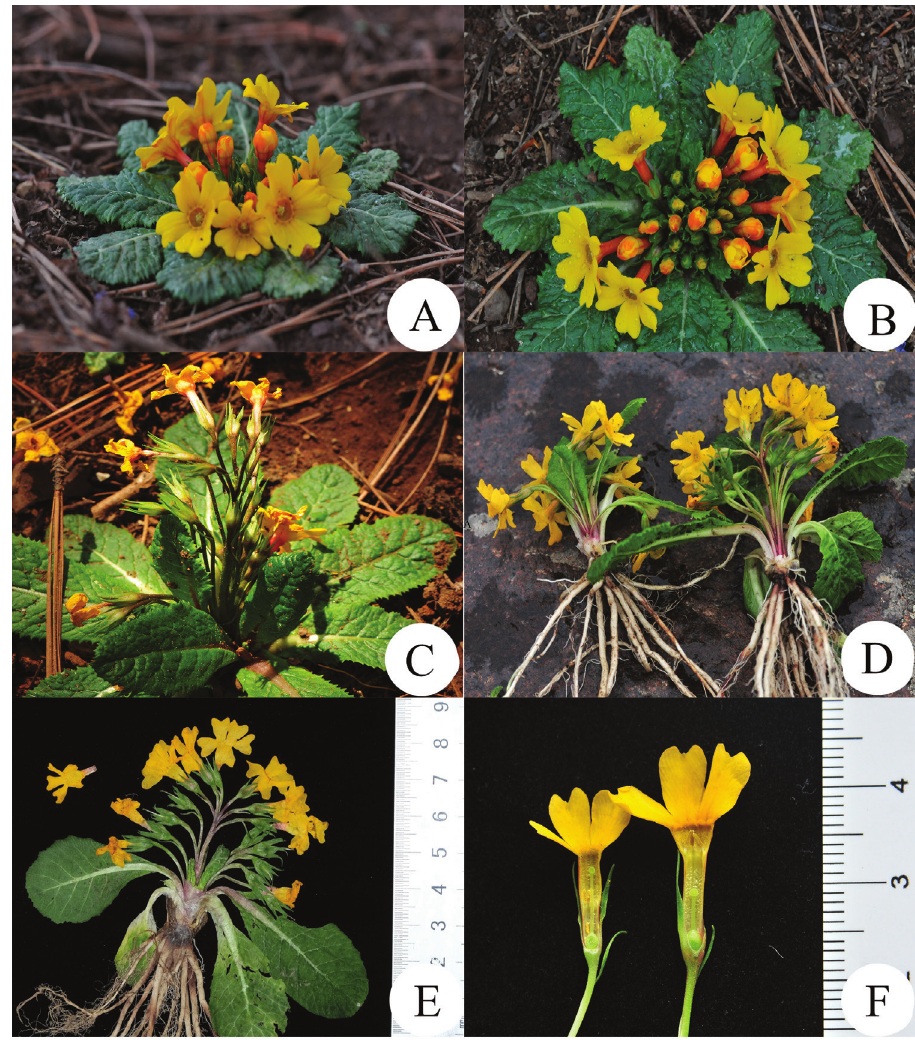
Figure 2. Primula dongchuanensis sp. nov. A, B Habit in early flowering C, D Habit in late flowering E specimen of late flowering F dissected corolla showing the anthers and stigma, pin flower (left) and thrum flower